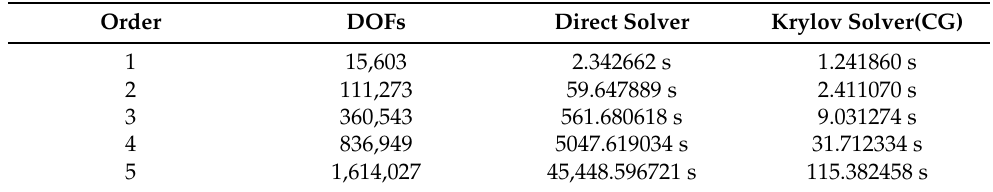
Table 1. Comparison of execution time between direct and Krylov solvers for SteadyThermal.py